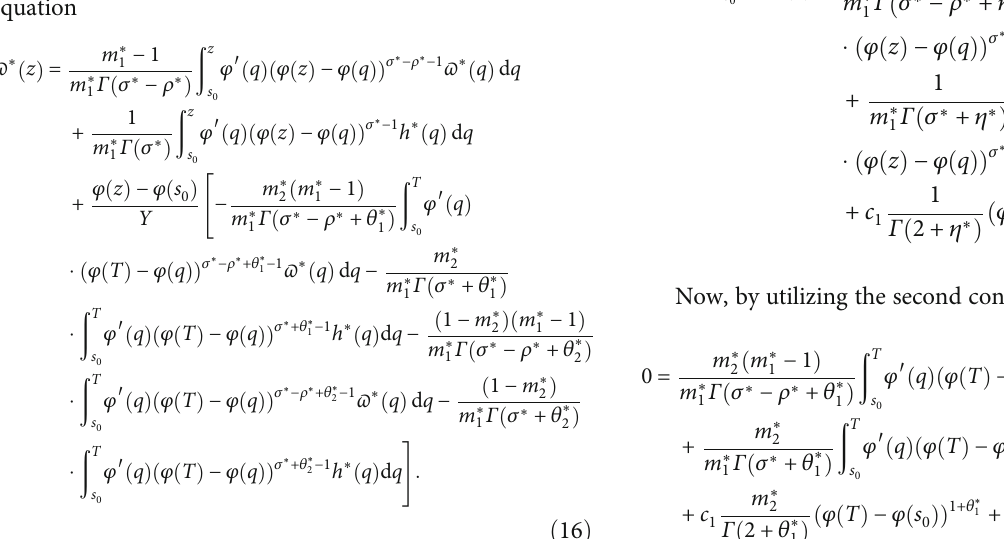
i ff ϖ ∗ satis fi es the fractional nonlinear double-order integral